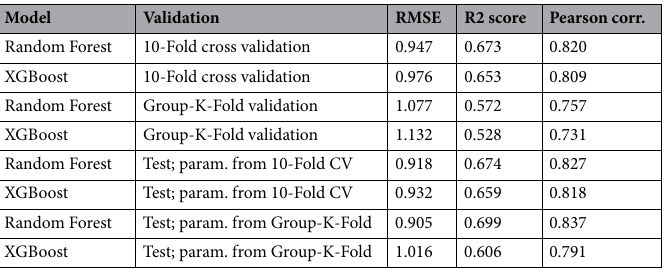
Table 3. Performance of the models.